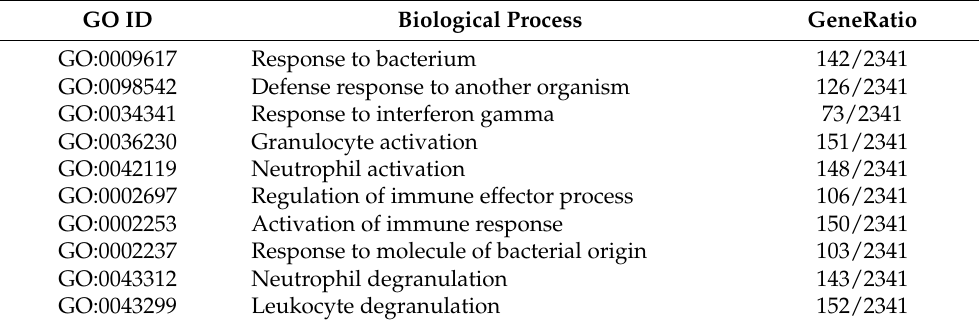
Table 4. Top 10 biological processes significantly (padj ≤ 0.01) enriched in genes differentially expressed in M1_C versus M0_C